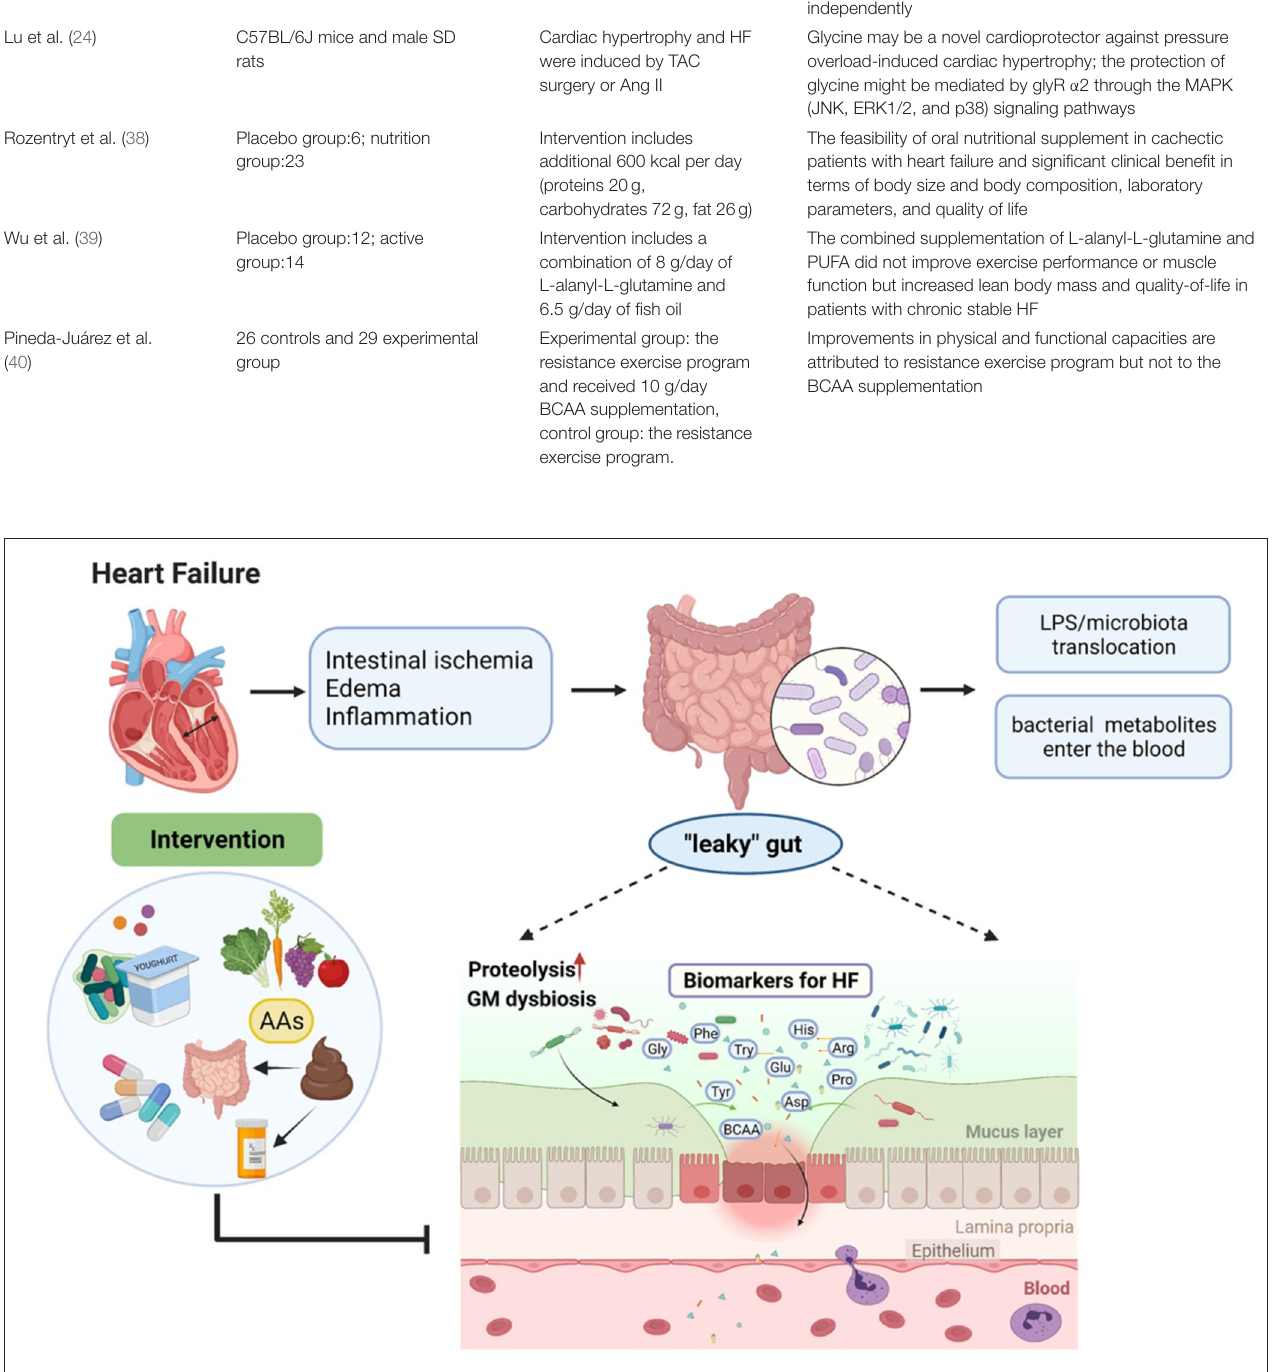
Frontiers in Cardiovascular Medicine |